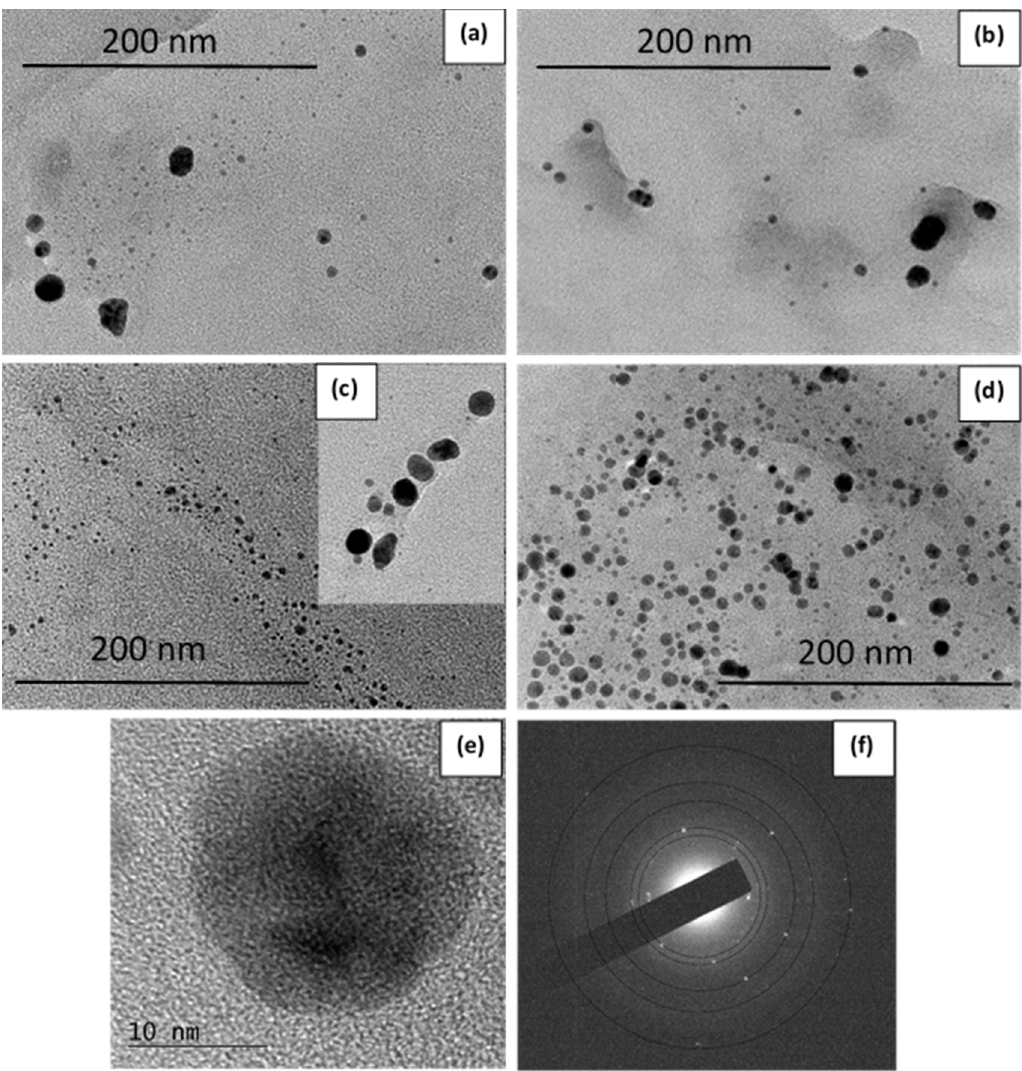
Figure 9. TEM images of the samples ( a ) Ag-72-150 rpm, ( b ) Ag-72-0 rpm, ( c ) Ag-144-150 rpm and